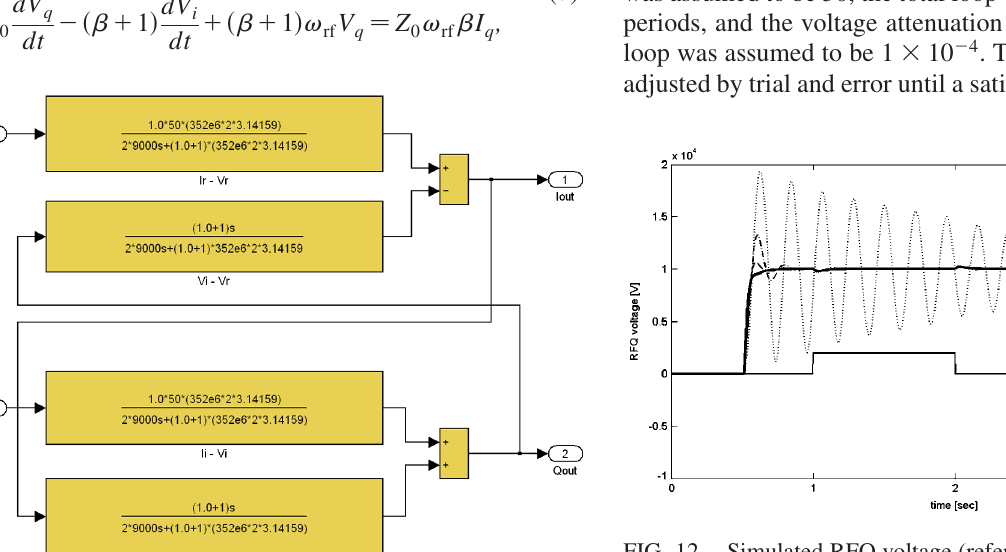
FIG. 12. Simulated RFQ voltage (referred to the primary side) in closed-loop mode; the pulse width was reduced to 200 (cid:2) s in the simulations, the beam pulse (not in scale) starts at t ¼ 100 (cid:2) s and ends at t ¼ 200 (cid:2) s